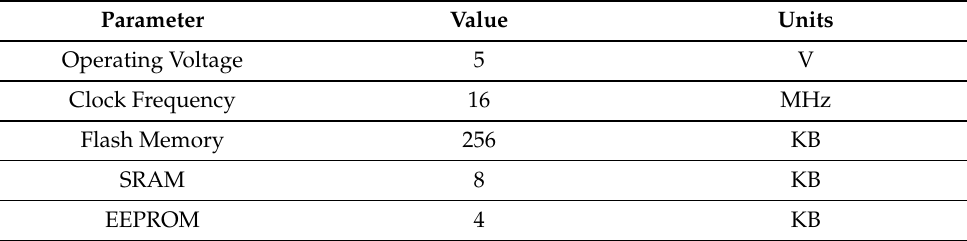
Table 2. Specifications of the ATmega2560 [29].